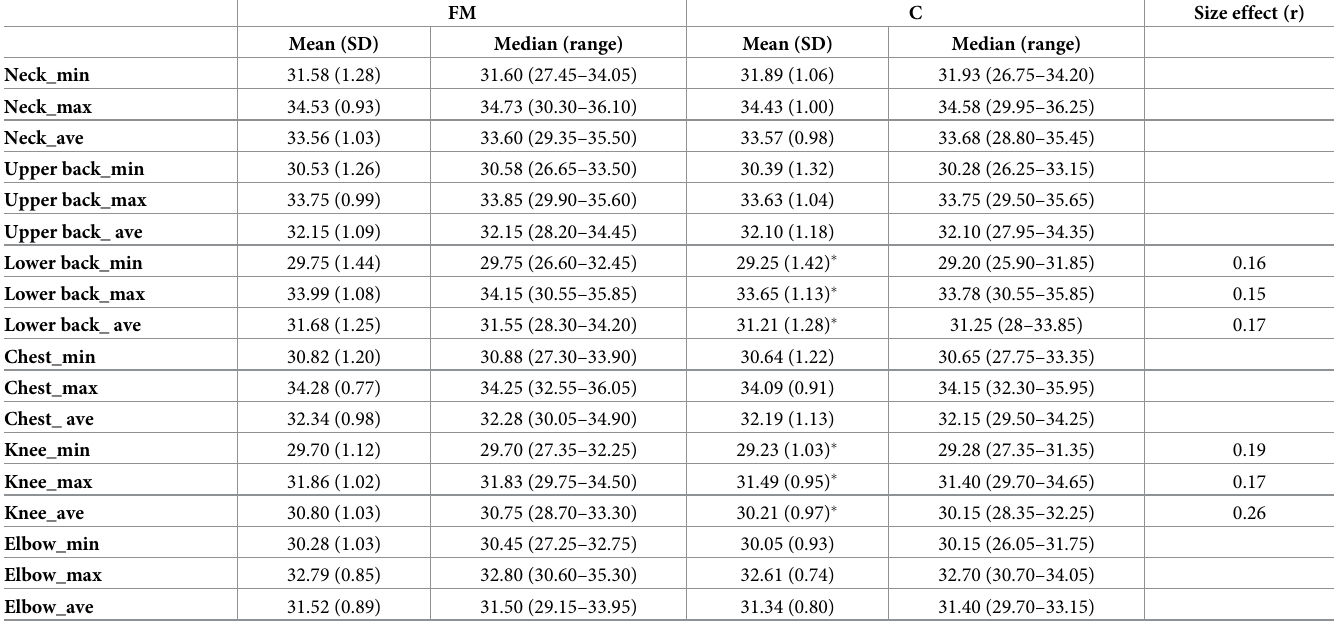
Table 2. Skin temperature of the study